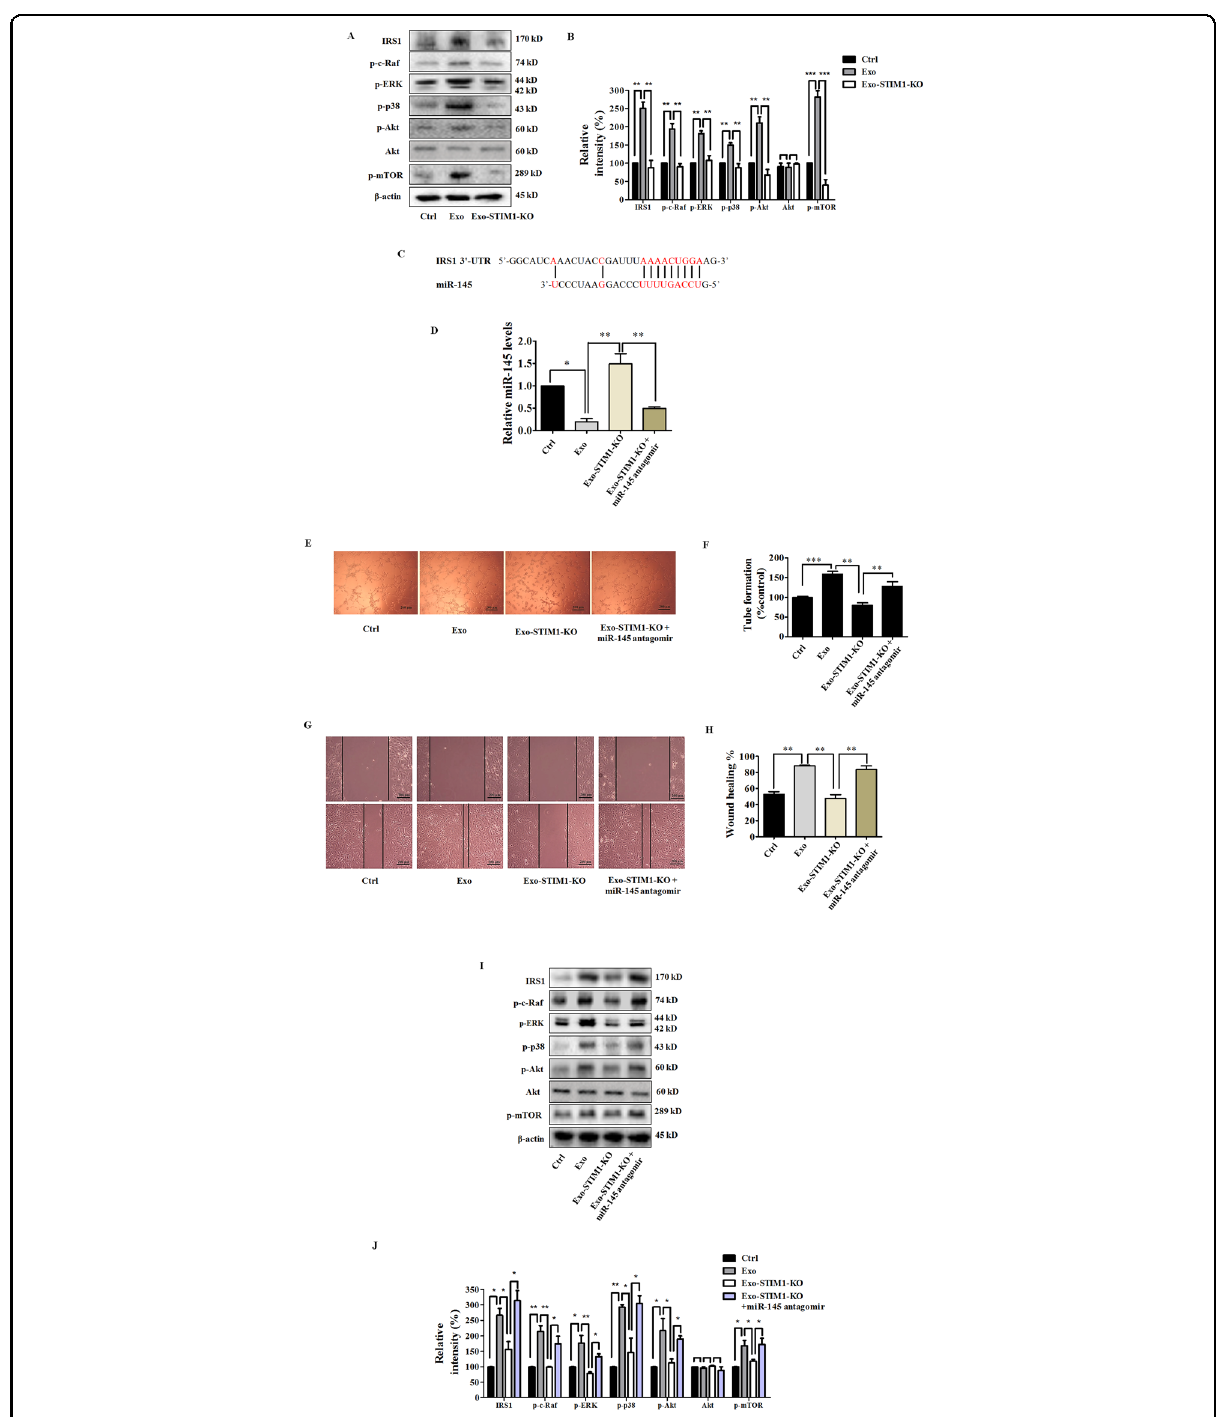
Fig. 5 Exo-STIM1-KO miR-145 inhibits angiogenesis through targeting IRS1 signal pathway in human umbilical vein endothelial cells (HUVECs). A Western blot analysis of IRS1 and its downstream signal proteins in HUVECs. B Quanti fi cation of the results in ( A ). C Schematic diagrams of miR-145 binding sites in the 3 ’ -UTR of IRS1. D The levels of miR-145 in HUVECs after various treatments. E Images of tube formation of HUVECs after various treatments. F Quanti fi cation of the results in ( E ). G Representative migration of HUVECs after various treatments. H Quanti fi cation of the results in ( G ). I Western blot analysis of IRS1 and the downstream signal proteins in HUVECs treated with Exo-STIM1-KO plus/or miR-145 antagomir. J Quanti fi cation of the results in ( I ). Data represent mean ± SEM from three independent experiments ( n = 3). * P < 0.05, ** P < 0.01, and *** P <